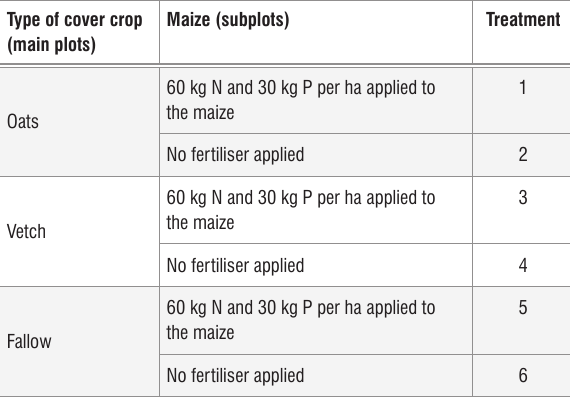
) and inorganic (P ) pools o i